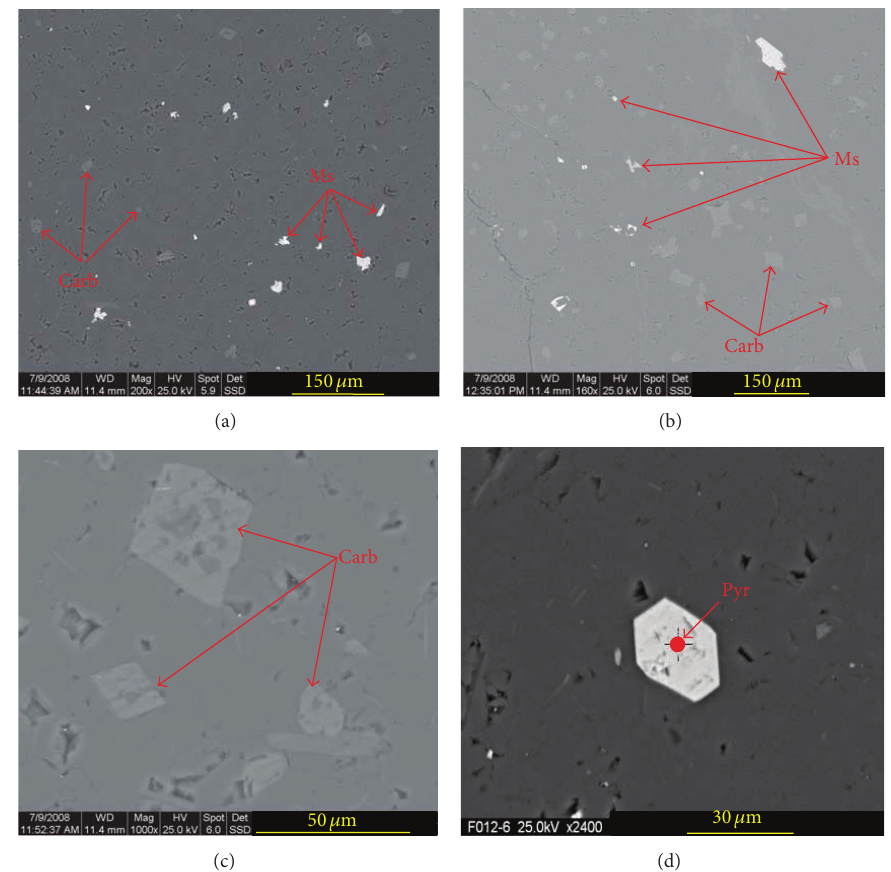
Figure 20: EBSD images for siliceous rock of the Bafangshan-Erlihe area (Carb: carbonate mineral, Ms: metal sulphide, Pyr: